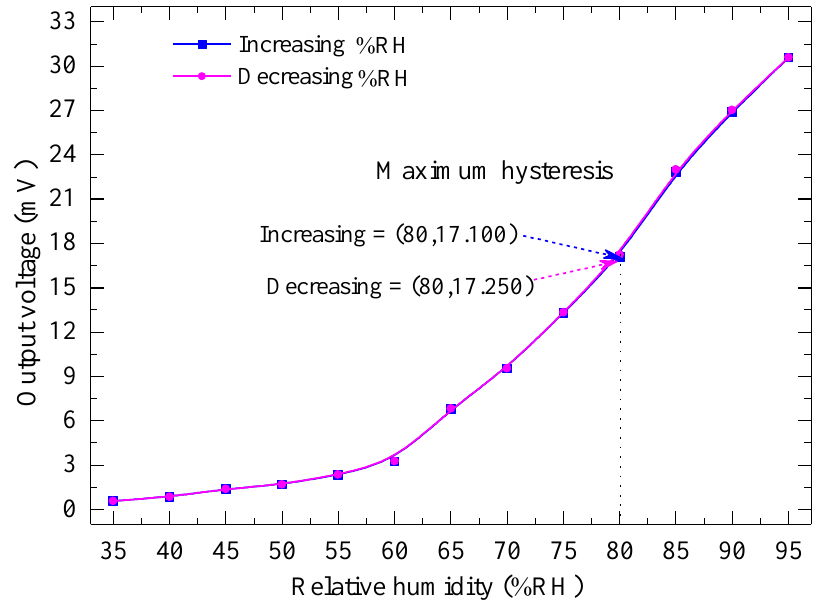
Figure 7. Output voltage vs. relative humidity at an operating temperature of 80 °C, corresponding to applied voltages of 6 V pp at a frequency of 4